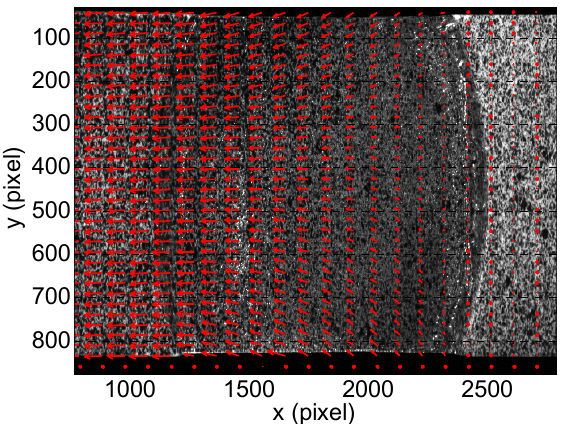
Figure 4: Detail of the displacement field obtained by DIC from the comparison of images 7 (the assumed reference one) and 16 (loaded specimen head on the left, fixed on the right); notice the different scales along the horizontal and the vertical direction.